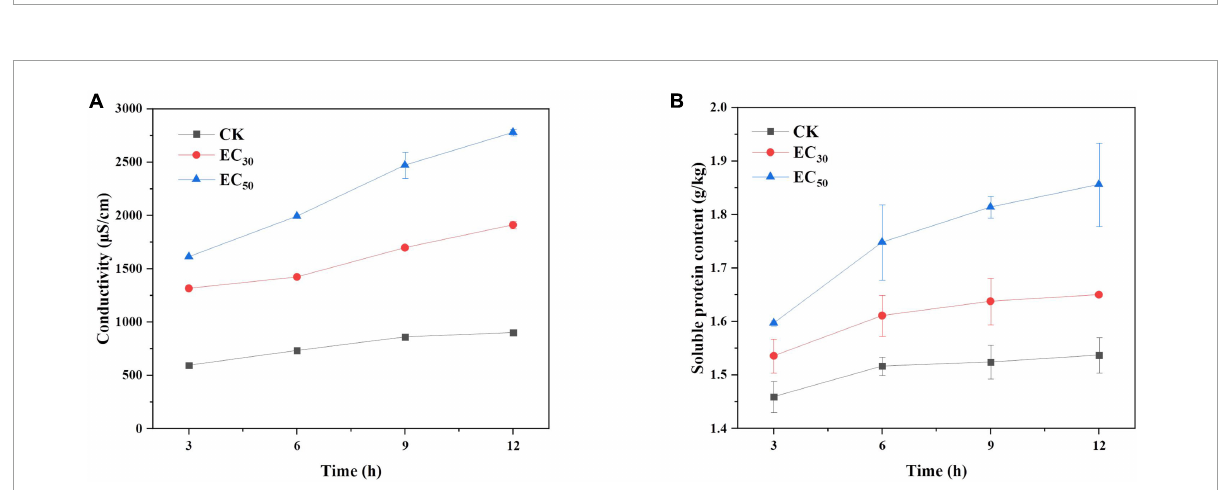
FIGURE4 Effect of JEO on extracellular conductivity (A) and soluble protein content (B) of B. cinerea mycelia during 12 h of incubation. B. cinerea was treated with different concentrations of JEO (0 as control, EC 30 , and EC 50 ). The bars represent the standard error of the mean ( n = 3).